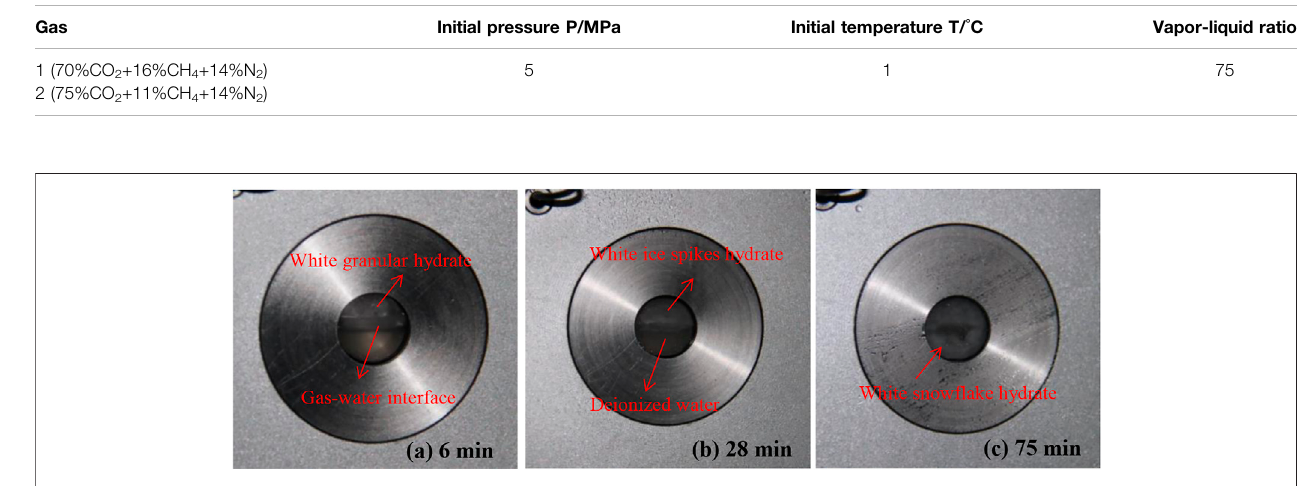
FIGURE 2 | Typical photos of the hydrate formation